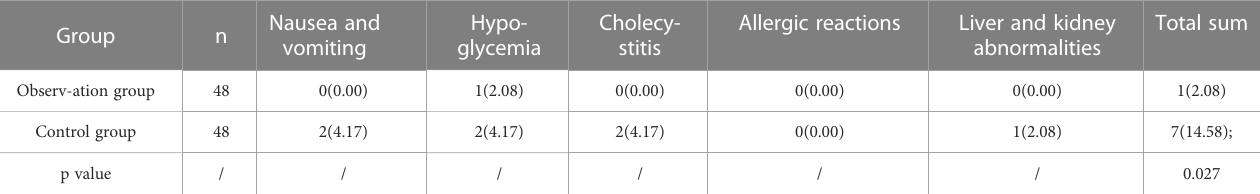
TABLE 4 Comparison of safety between control and observation groups [n （ % ） ].